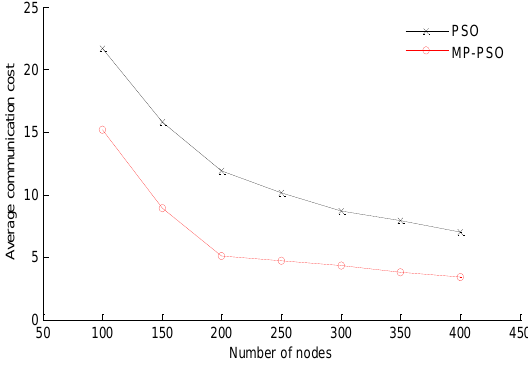
Figure 13. The comparison of energy consumption.